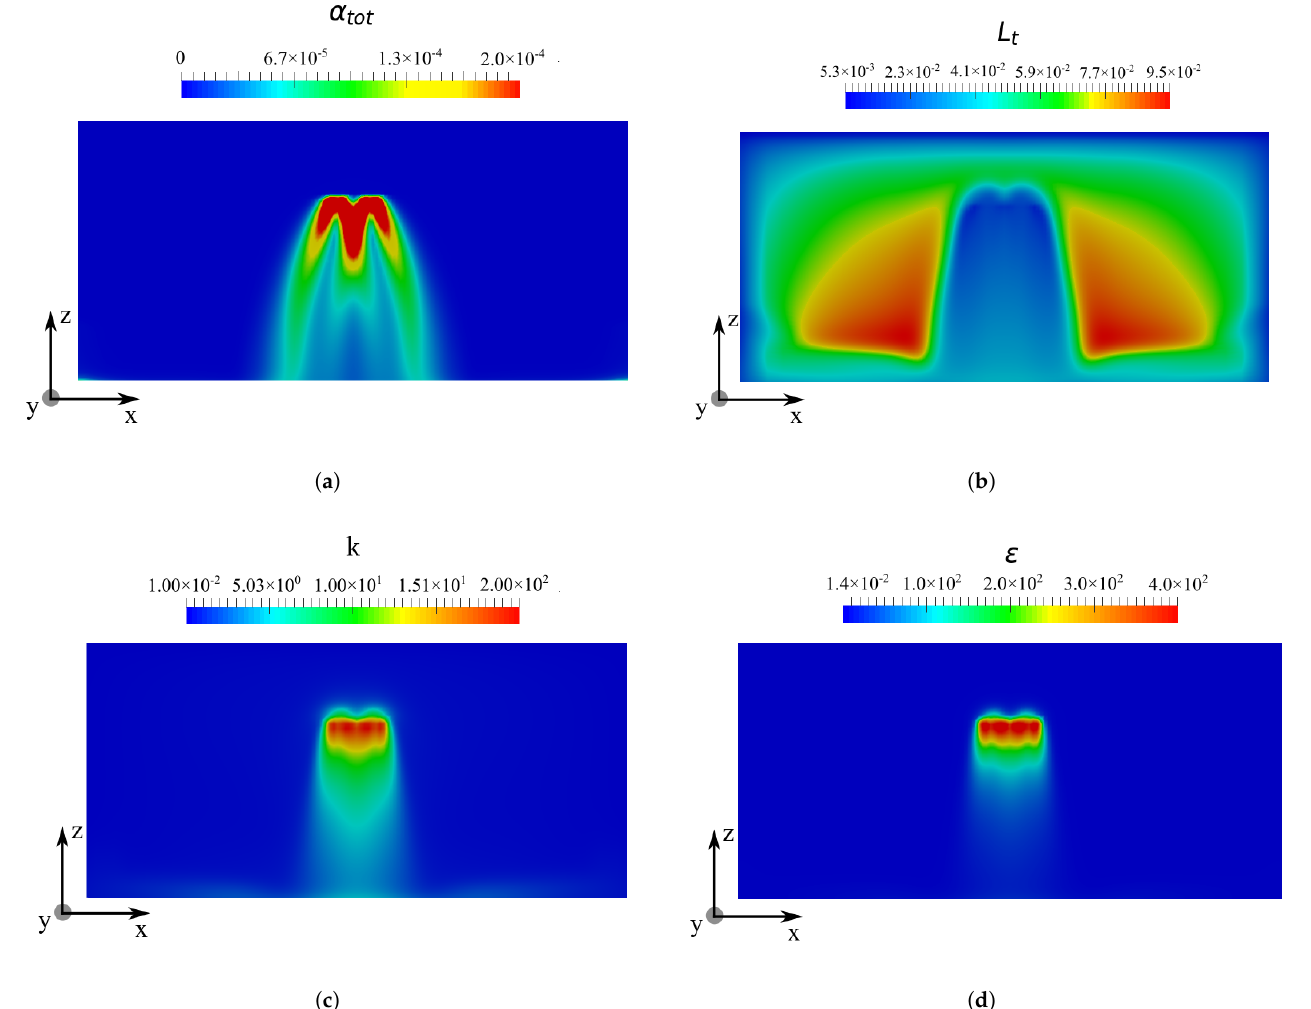
Figure 15. Properties on the XZ plane at 30 s; ( a ) droplet volume fraction α tot , ( b ) integral length scale L t (m), ( c ) turbulent kinetic energy k (m 2 /s 2 ), and ( d ) turbulent dissipation rate ε (m 2 /s 3